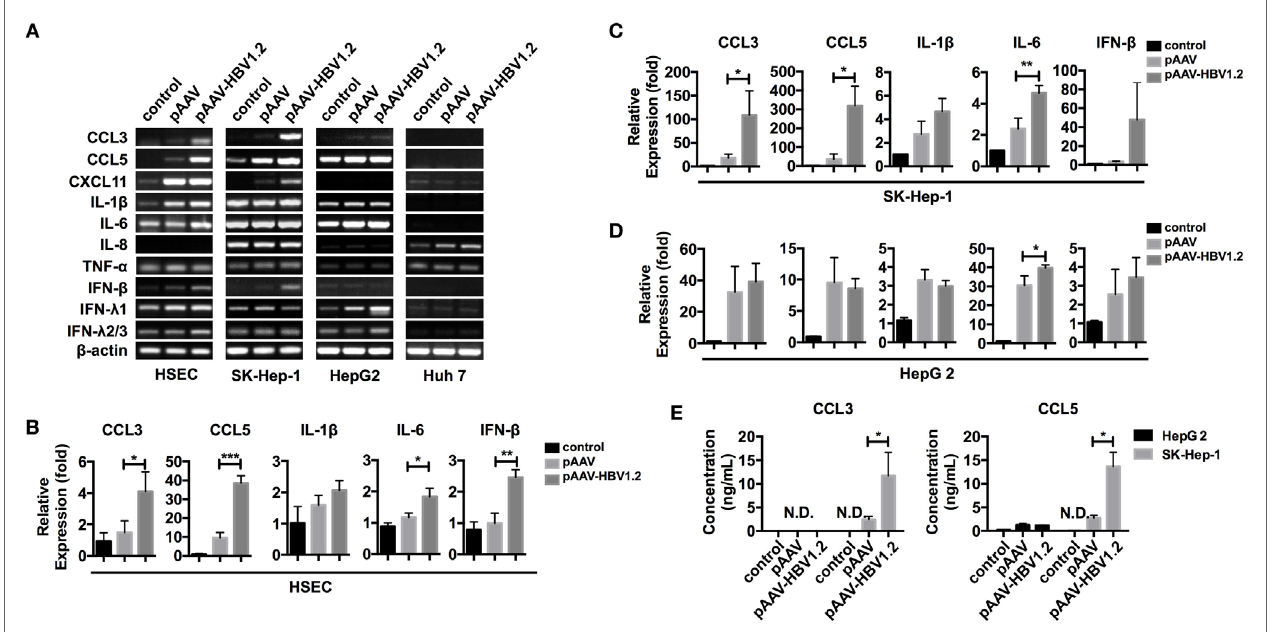
FigUre 3 | ccl3 and ccl5 expression increases in liver-derived cells upon hBV plasmid transfection . (a–e) The pAAV-HBV1.2 or pAAV plasmid (1 μ g/ml) was transfected into liver-derived cells (0.2 μ g/ml for HSECs). Transfection reagent was only applied as a control. RNA isolation and reverse transcription proceeded 48 h post-transfection. (a) PCR detection of inflammation-associated chemokine and cytokine mRNAs. (B–D) Real-time qPCR determination of chemokine and cytokine mRNA expression ( n = 3). (e) ELISA determination of the secreted CCL3 and CCL5 levels in the cell culture supernatant ( n =